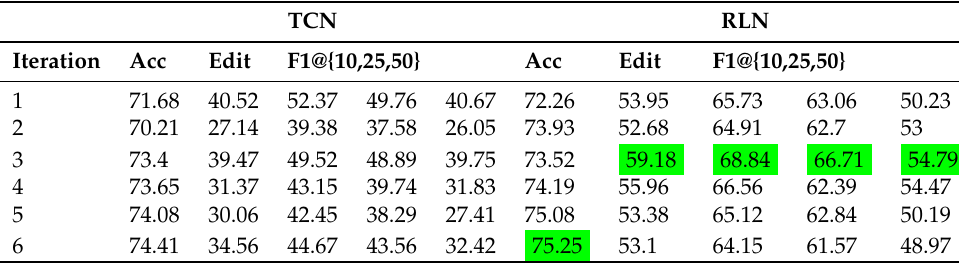
Table 13. RL-SSI in the Sandwich context.